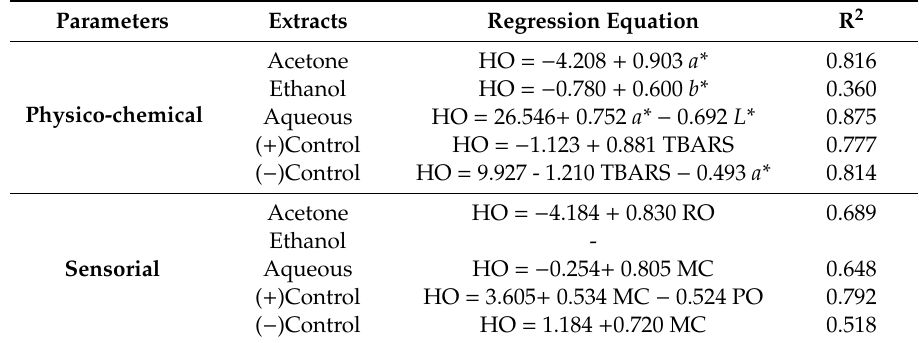
Table 6. Stepwise multiple linear regression equations of Hamburger Oder (HO) versus physico-chemical and sensorial parameters of beef burger meat stored at 4 ◦